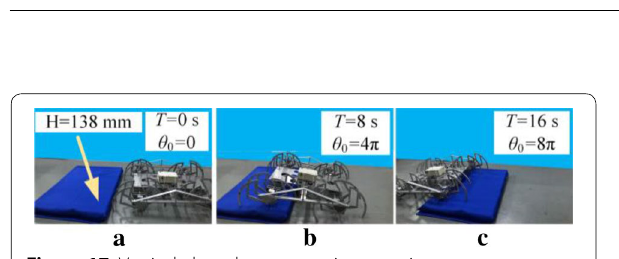
Figure 17 Vertical obstacle-surmounting experiments